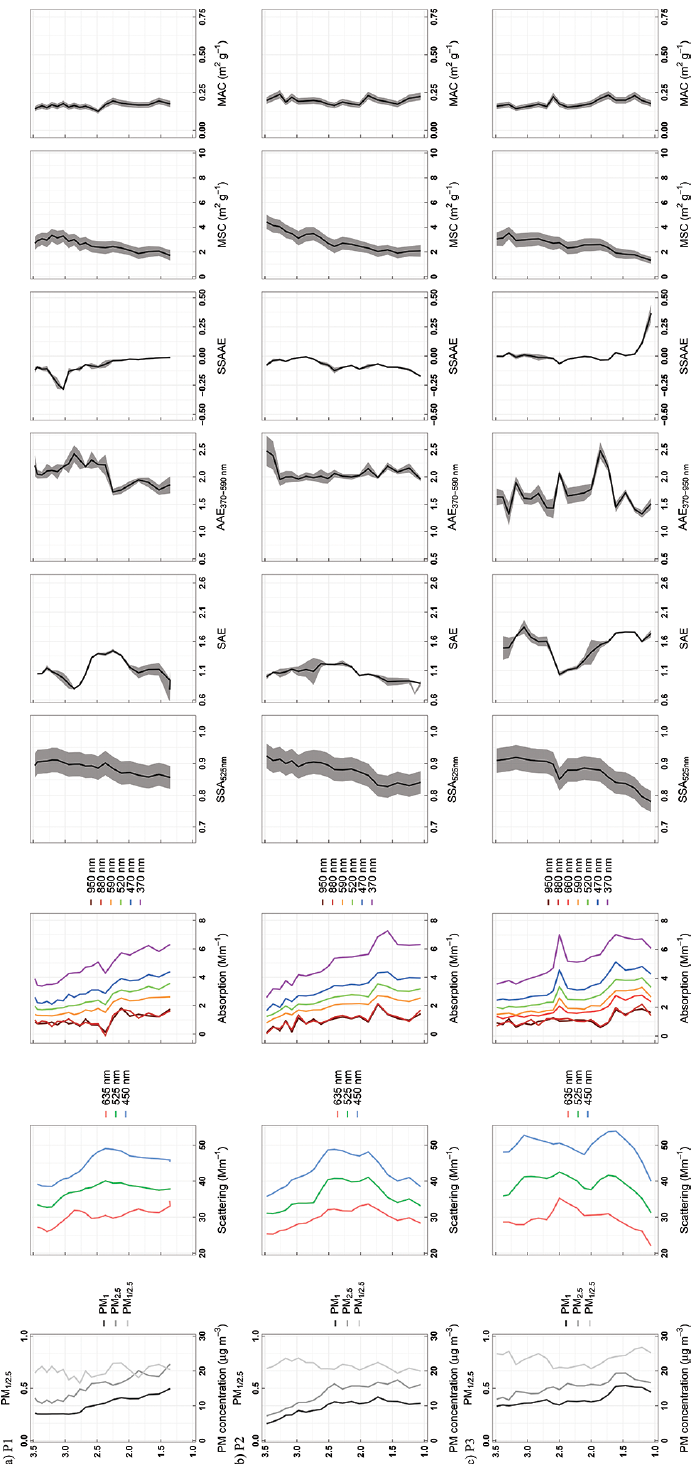
Figure 7. Vertical profiles from the extensive and intensive optical properties during the SDE period: scattering and absorption coefficients; σ sp and σ ap , respectively, for several wavelengths; PM 1 , PM 2 . 5 concentration and the PM 1 / 2 . 5 ratio; single-scattering albedo (SSA); scat- tering Ångström exponent (SAE); absorption Ångström exponent (AAE); single-scattering albedo Ångström exponent (SSAAE); and mass scattering and absorption cross section, MSC and MAC, respectively, from left to right, for the aircraft-borne measurements for the (a) P1, (b) P2 and (c) P3 vertical profile. The shadowed areas around the intensive optical properties denote the standard error of the variables. Atmos. Chem. Phys., 21, 431–455,